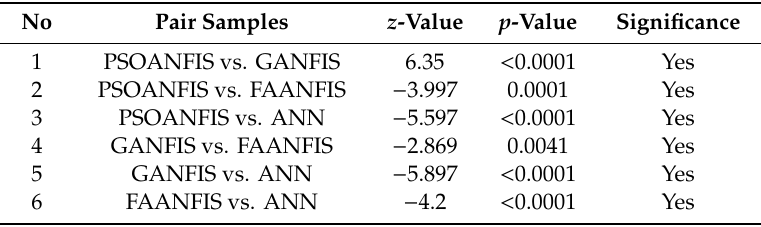
Table 5. Non-parametric test using testing dataset.